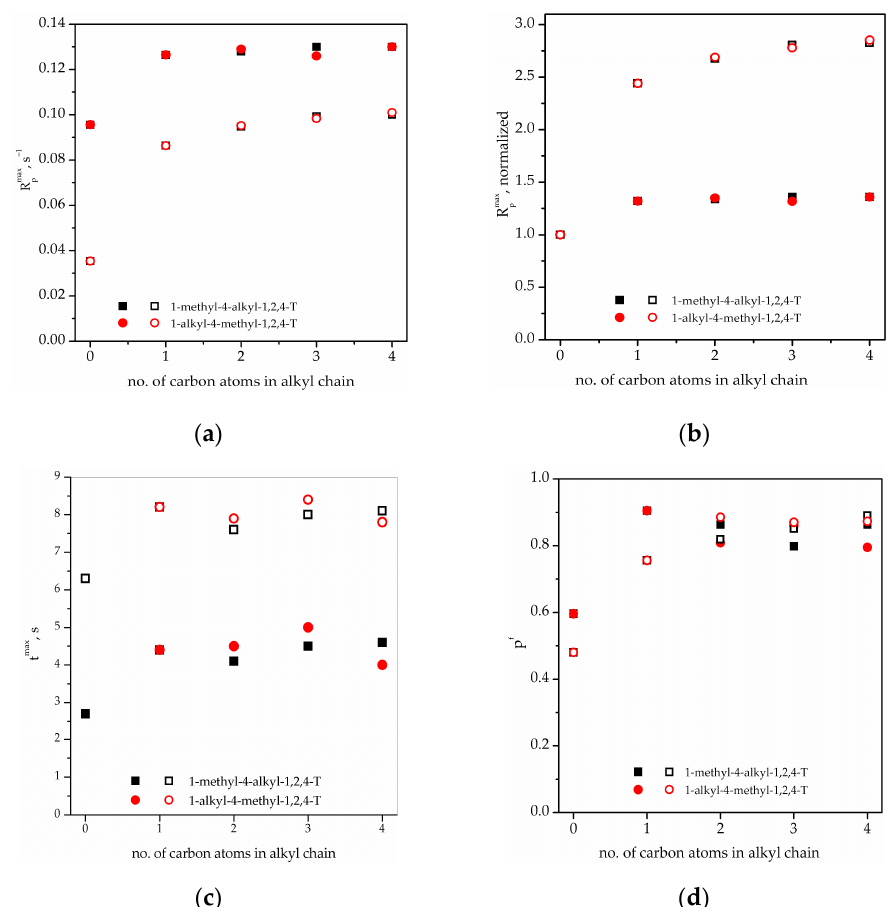
Figure 6. Kinetics curves of photopolymerization of thiol–ene systems ( a ) PETMP+TATT and ( b ) PETMB+TATT in a mixture of 1,4-dialkyl-1,2,4-triazolium ionic liquids with propylene carbonate. Solid line—systems with 1-methyl-4-alkyl-1,2,4-triazolium IL; dashed line—systems with 1-alkyl-4- methyl-1,2,4-triazolium IL.